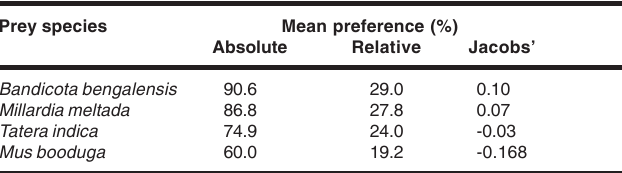
Table 2. Relative preference of different prey species by the Barn Owl ( Tyto alba ) under multiple-choice experiments (four owls tested with five trials each)